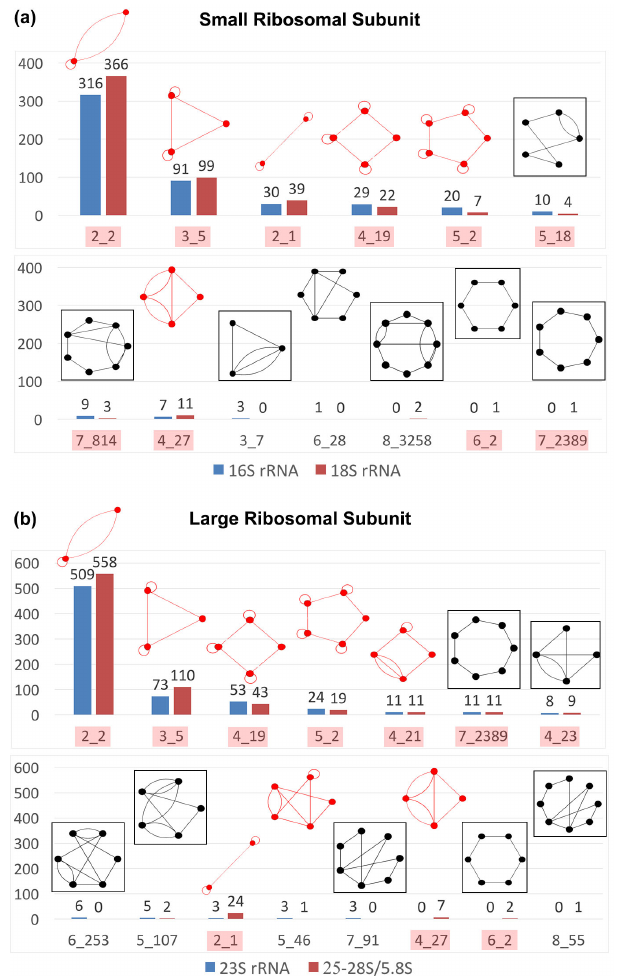
Figure 7. Subgraphs in ribosomes. Dual graph topologies that emerge as subgraph blocks in the ( a ) small (16S and 18S ribosomal RNAs (rRNAs)) and ( b ) large (23S and 25–28S/5.8S rRNAs) ribosomal subunits of various prokaryotic and eukaryotic species (see Tables S5–S6 in the Supplementary data for PDB files used). Subgraph IDs highlighted in red are also common subgraphs shown in Figures 5 and 6. Subgraphs with a black box are unique to rRNA structures in the entire representative RNA structure